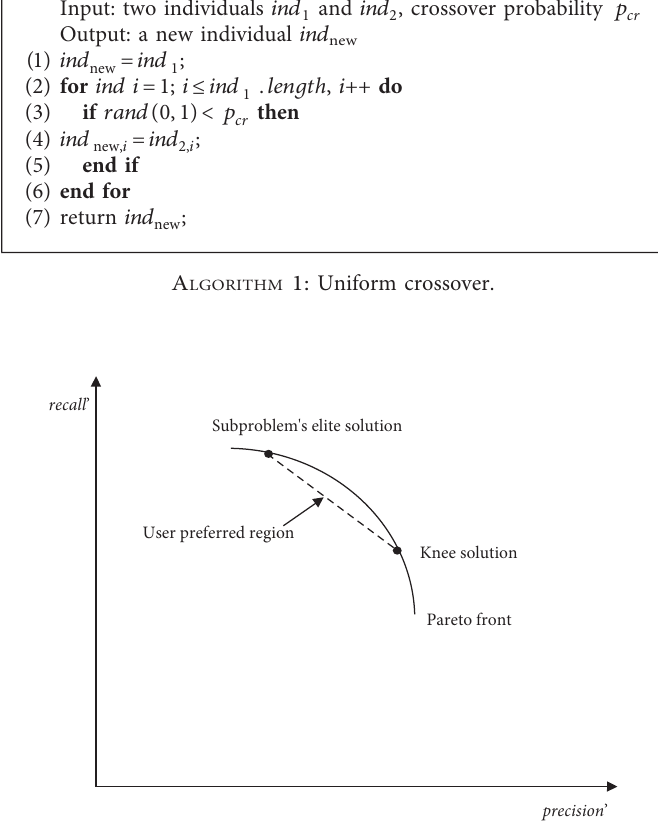
Figure 3: An example of knee solution and user preferred